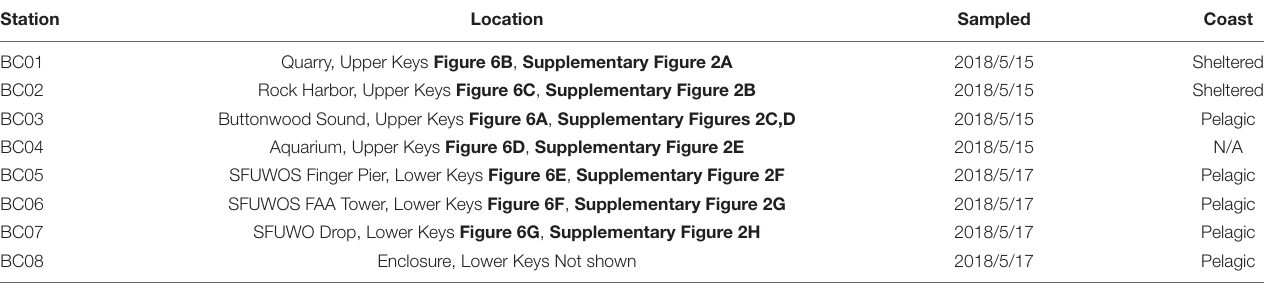
TABLE 1 | Florida Keys eDNA collection sites. “Sheltered” and “Pelagic” are qualitative descriptions of the general connectedness observed between the sites and open ocean.